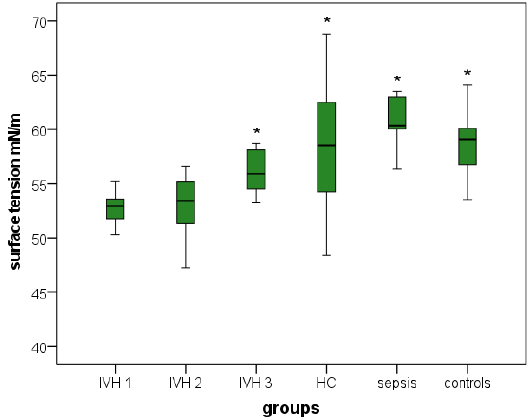
Figure 1. Boxplots: Distribution of surface tension values in the six investigated groups. IVH 1, patients with intraventricular hemorrhage without/before primary intervention; IVH 2, patients with intraventricular hemorrhage at 4–28 days; IVH 3, patients with intraventricular hemorrhage 44–357 days after primary intervention; HC, hydrocephalus patients between 2 days and 14 years old; sepsis, patients aged 2–16 days suffering from neonatal sepsis; controls, patients between 2 days and 84 years old without a conclusive proof of neurological pathologies, cerebral inflammations or other CSF abnormalities. Boxplots present results as medians between the 1st and 3rd quartiles. Whiskers comprise the range from minimum to maximum. Significant differences between groups in comparison with IVH group 1 are marked with an asterisk. * A p -value < 0.05 and a confidence interval > 0.95 were considered statistically significant.